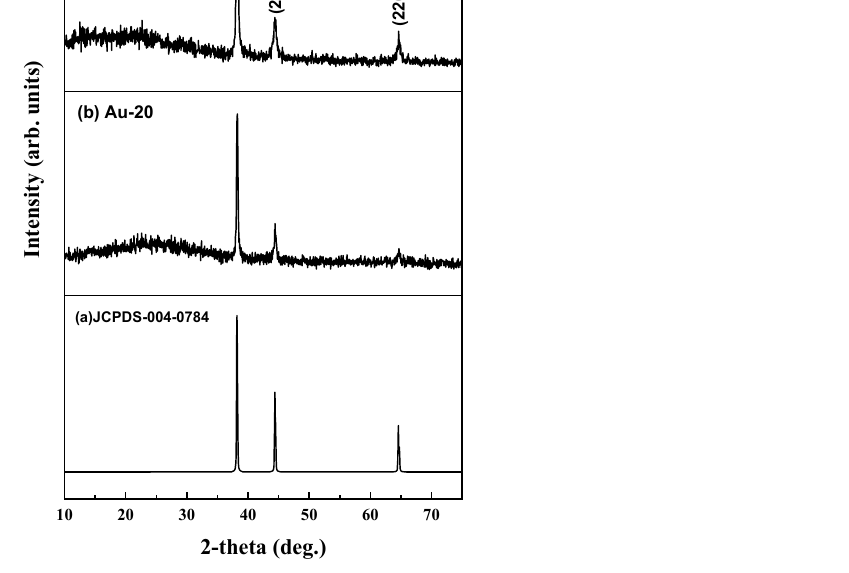
Figure 4. XRD pattern of ( a ) the JCPDS data card 04-0784 for gold; ( b ) Au-20; ( c ) Au-PVP-20. The maximum intensity peak at 38.24 ◦ for both samples indicated the preferential growth in the (111) direction, which is in agreement with previously reported results